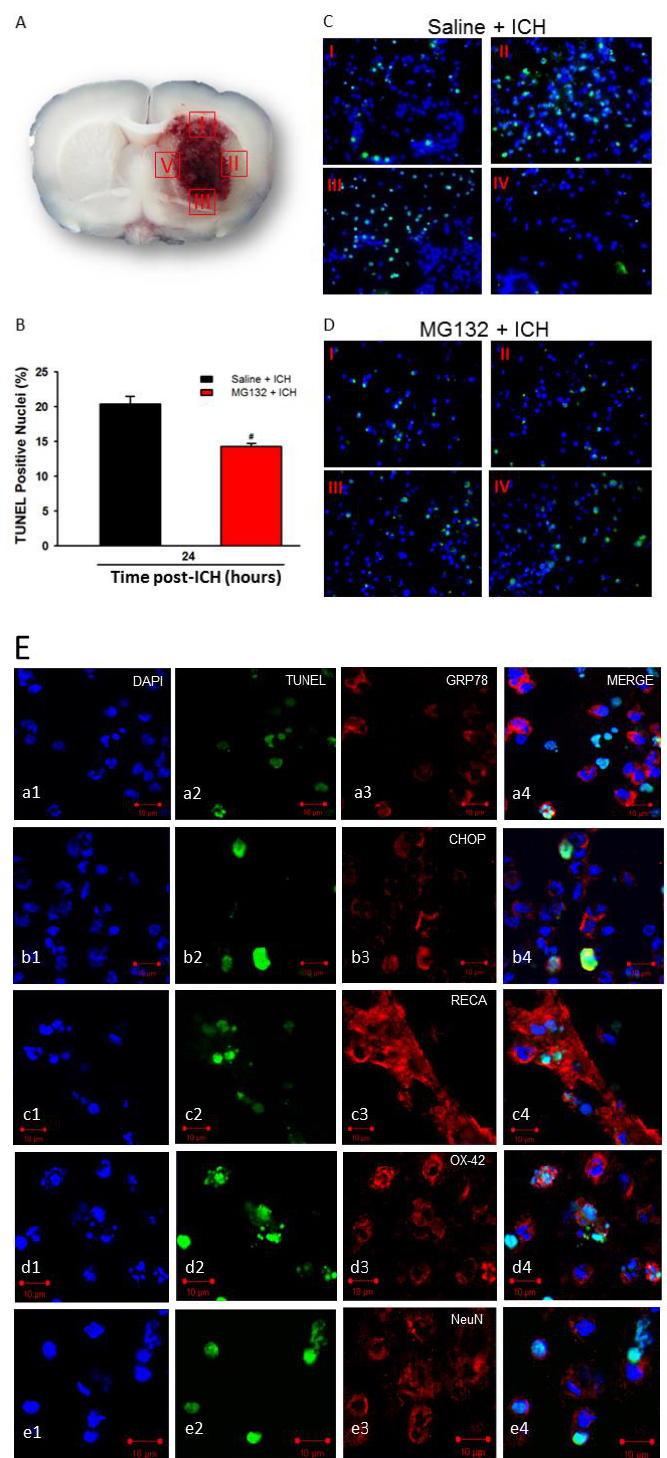
Figure 10. Neuronal apoptosis in hemorrhagic striatal rat at 1 day post-ICH injury. Representative TUNEL-positive staining of apoptotic cells in four regions around the perihematomal area ( A , I–IV). Statistical measurement of apoptotic cells subjected to ICH injury in the Saline + ICH and MG132 + ICH groups ( B ), respectively. Representative TUNEL-positive image of Saline + ICH ( C ) and MG132 + ICH ( D ), respectively. Values are indicated by means ± SEM; n = 4 each group, # p < 0.05; as compared to the Saline + ICH group. TUNEL staining was conducted following GRP78 ( a ), CHOP ( b ), RECA ( c ), OX-42 ( d ) and NeuN ( e ) on the brain sections of the perihematomal area of ICH striatal ( E